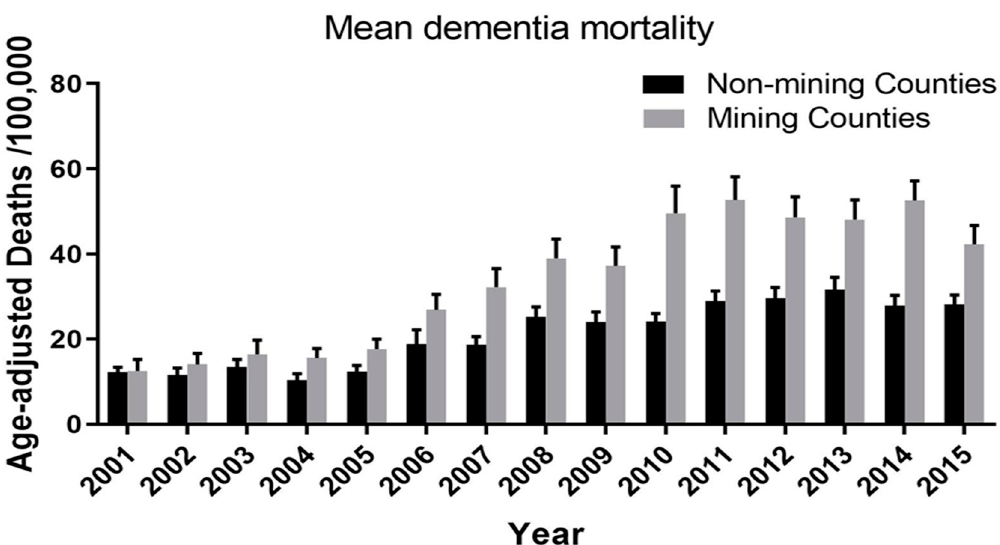
Figure 3. Age-adjusted vascular and unspecified dementia mortality / 100,000 population in mining vs. non-mining counties in West Virginia over the years spanning 2000–2015. A 2-way repeated measures ANOVA was used to compare age-adjusted dementia mortality / 100,000 population. An overall significant impact of mining on dementia mortality was found (F = 23.16; df = 1, 52; p < 0.0001). There was also a significant interaction between year and mining (F = 5.52; df = 14, 728; p < 0.0001) and a significant overall e ff ect of year (F = 41.22; df = 14, 728; p < 0.0001). An unpaired t-test found significantly higher peak dementia mortality in the MTM counties (Figure 4b; t = 3.77; df = 52; p = 0.0004). MTM counties had a mean ( ± SEM) peak value of 67.5 ± 4.81 vs. 47.83 ± 2.82 for the non-MTM